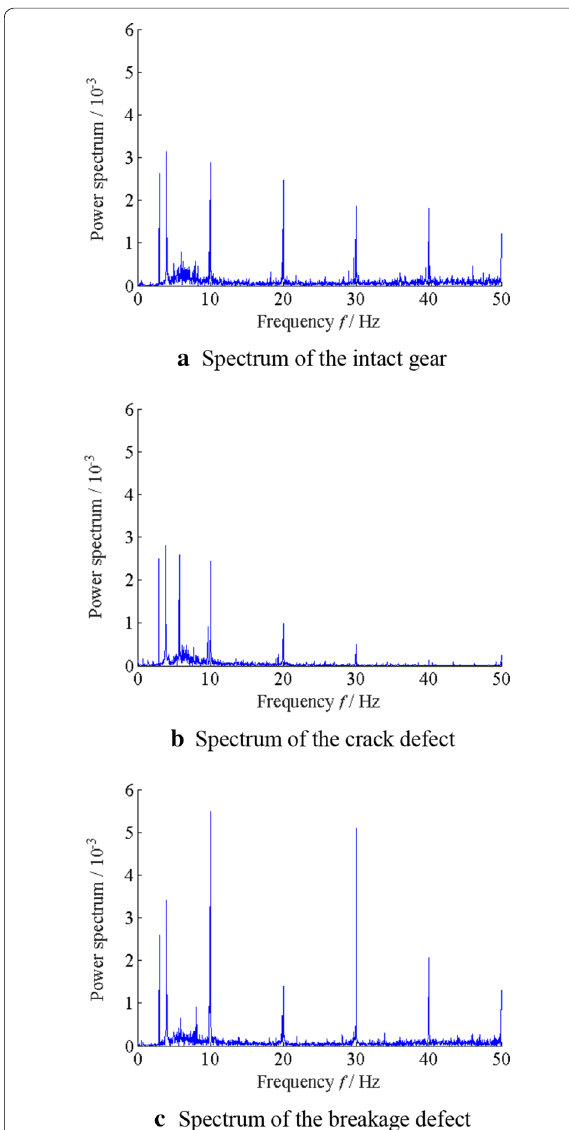
Figure 12 Spectra of instantaneous speed of the output shaft encoder